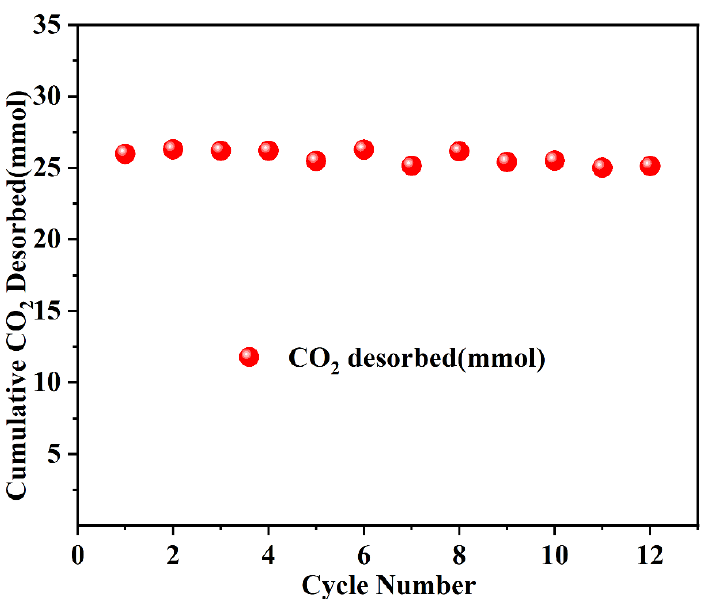
Figure 9. Stability of KHCO 3 − H 2 O − IPA solution (36 wt % IPA).